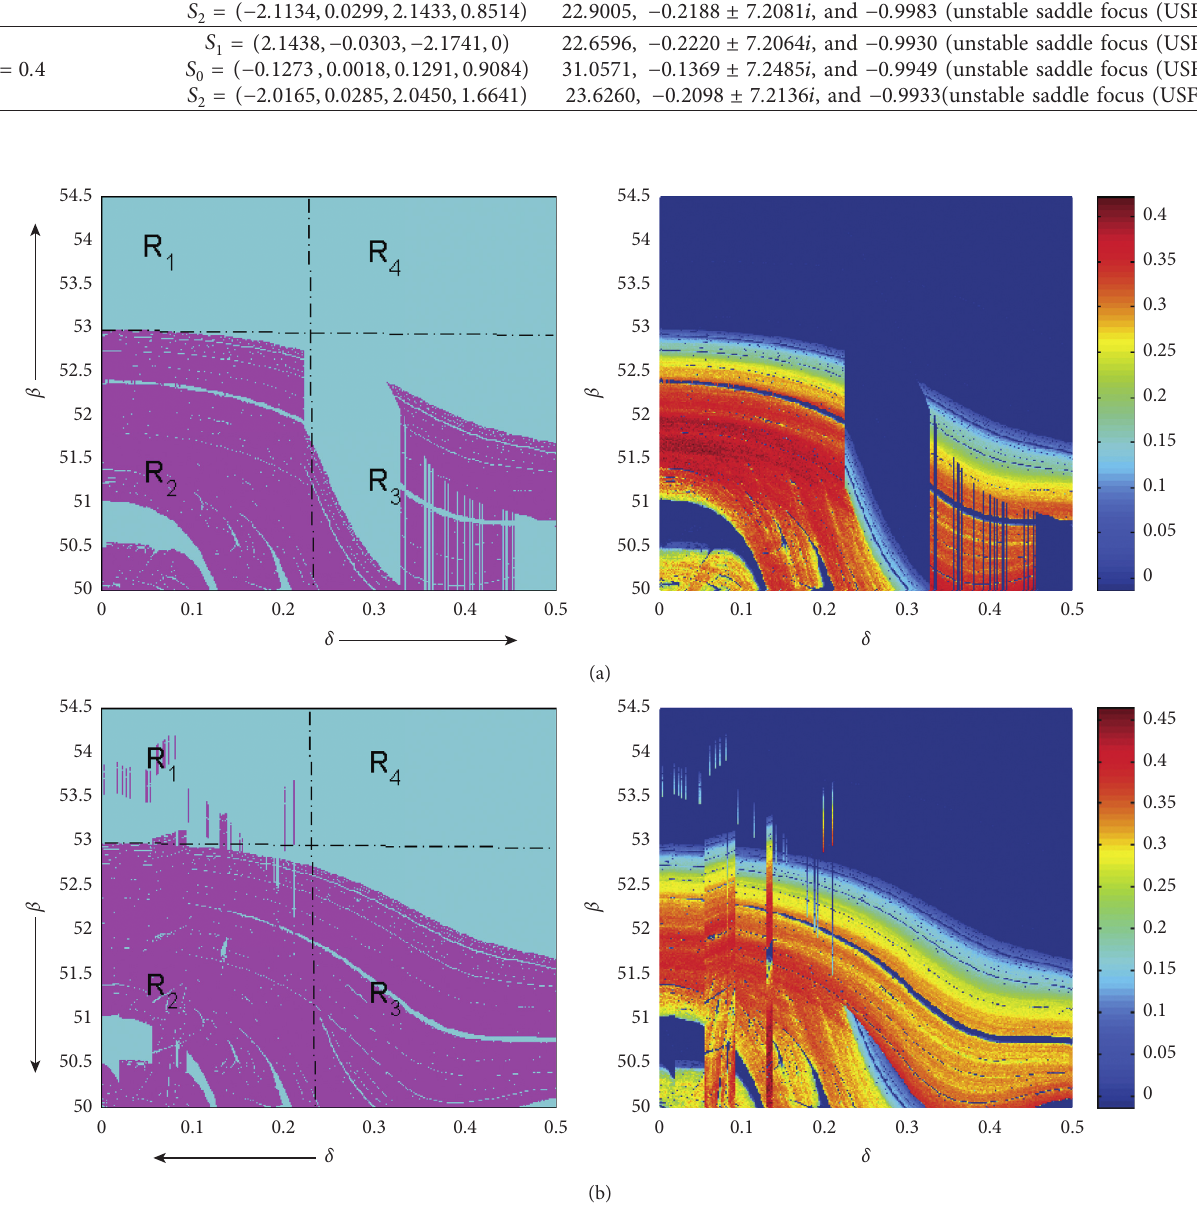
Figure 4: Two-parameter diagram (left) and the corresponding standard Lyapunov stability diagram (right) in the ( δ , β ) plane when increasing (a) and decreasing (b) both control parameters. Both diagrams show the effectiveness of the controller in the coexisting region for ε � 2 . 1438. Other parameters are those of Figure 1.